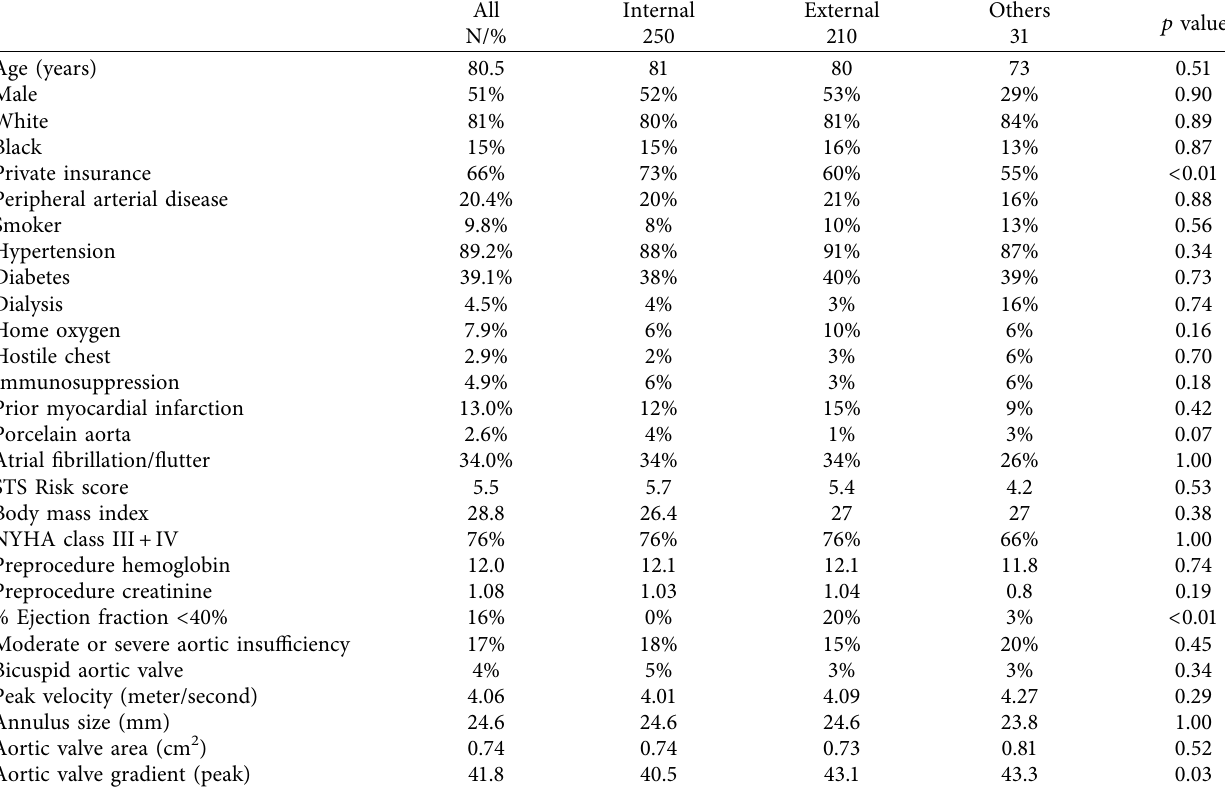
Table 1: Patient characteristics of 491 consecutive patients undergoing TAVR at a single